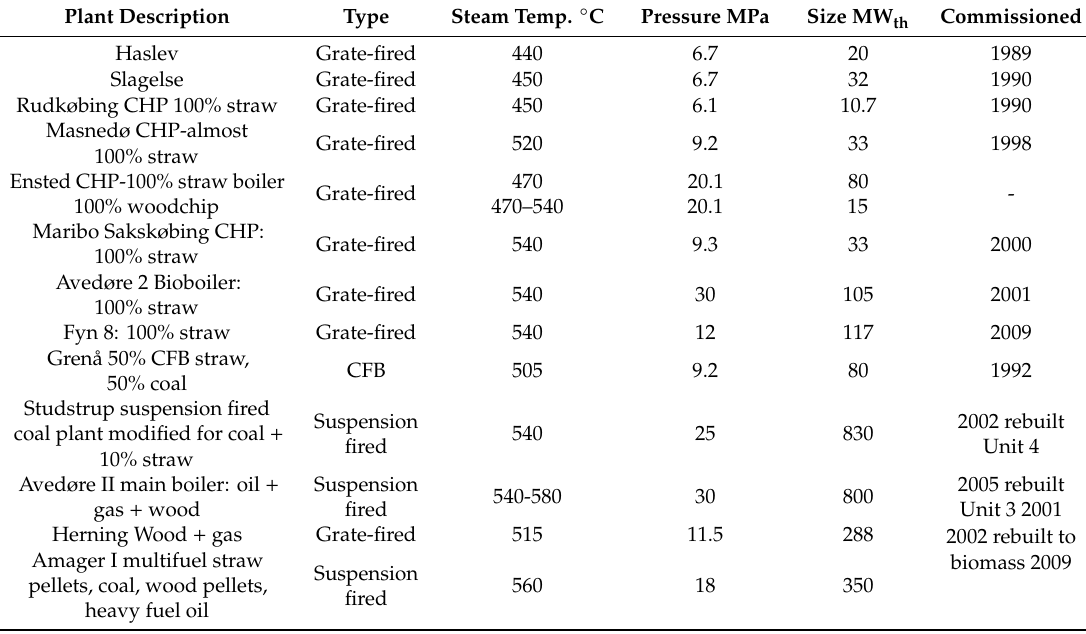
Figure 1. Examples of biomass-fired boilers: straw-fired vibrating-grate boiler [12]. Table 1. Biomass and co-firing plants in Denmark